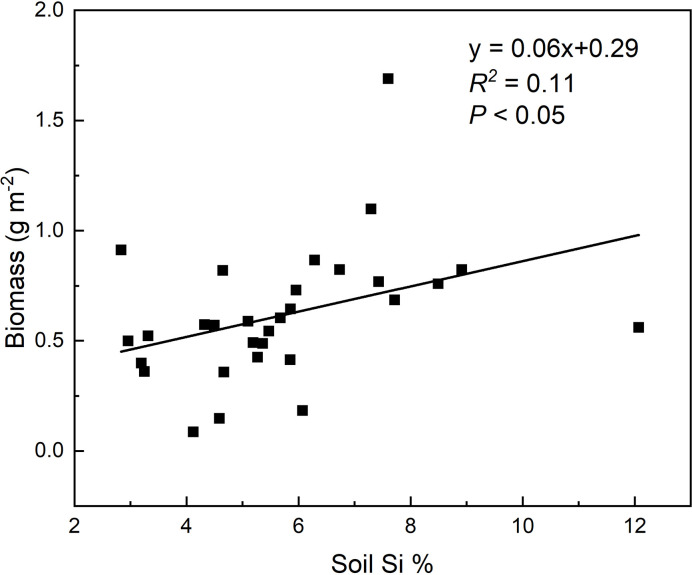
Relationships between soil noncrystalline Si concentrations and biomass of sample plots.